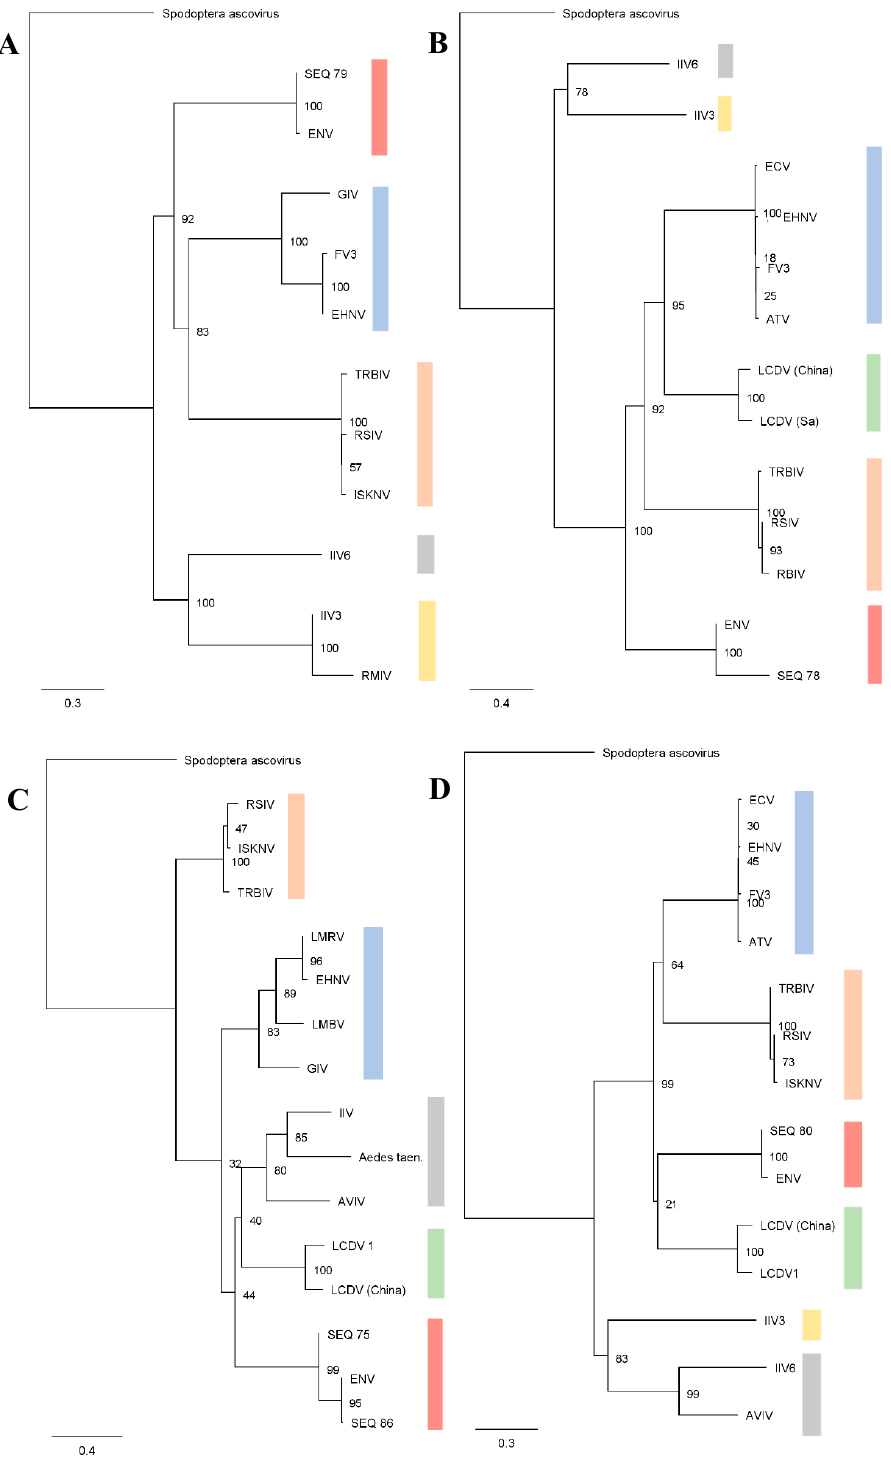
Figure 1. Substitution-rate optimized maximum likelihood phylogenetic trees of putative ENV DNA-dependent DNA polymerase ( A ), DNA-dependent RNA polymerase ( B ), major capsid protein ( C ), and ATPase ( D ) sequences (SEQ#) mapped with related iridoviruses. Alignments were based on nucleotide sequences for the major capsid protein and amino acid sequences for all other trees. Branch labels indicate bootstrap support values for 100 re-samplings and the scale bar indicates substitution rate. GenBank reference sequences and contig IDs are listed below (Table 2), with colors indicating genera groups. Putative ENV sequence lengths are listed in Table